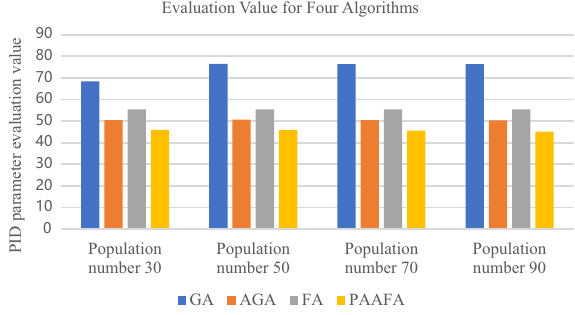
Figure 5. Comparison of PID parameter evaluation values of the four algorithms for different population sizes.